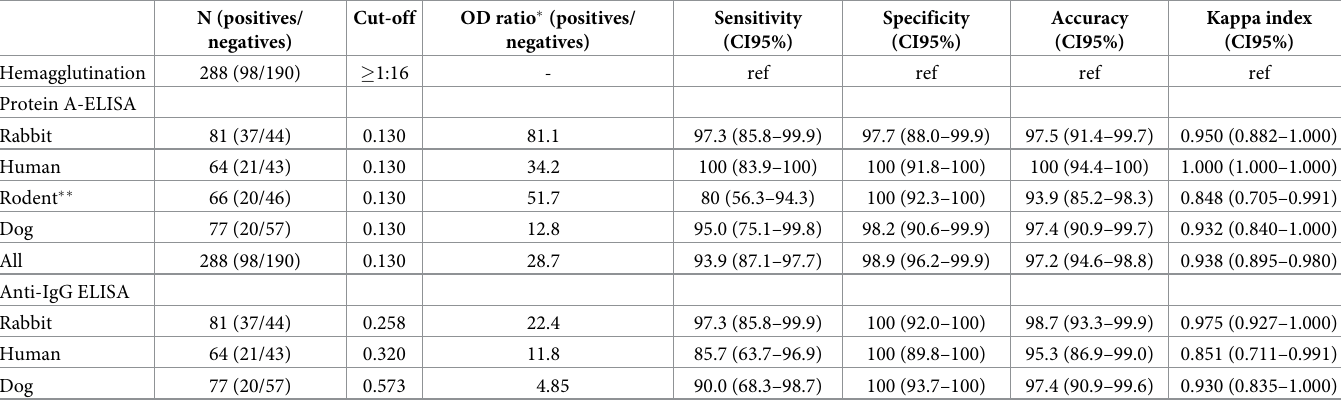
Table 1. Cut-offs and diagnostic performance of Protein A-ELISA and Anti-IgG